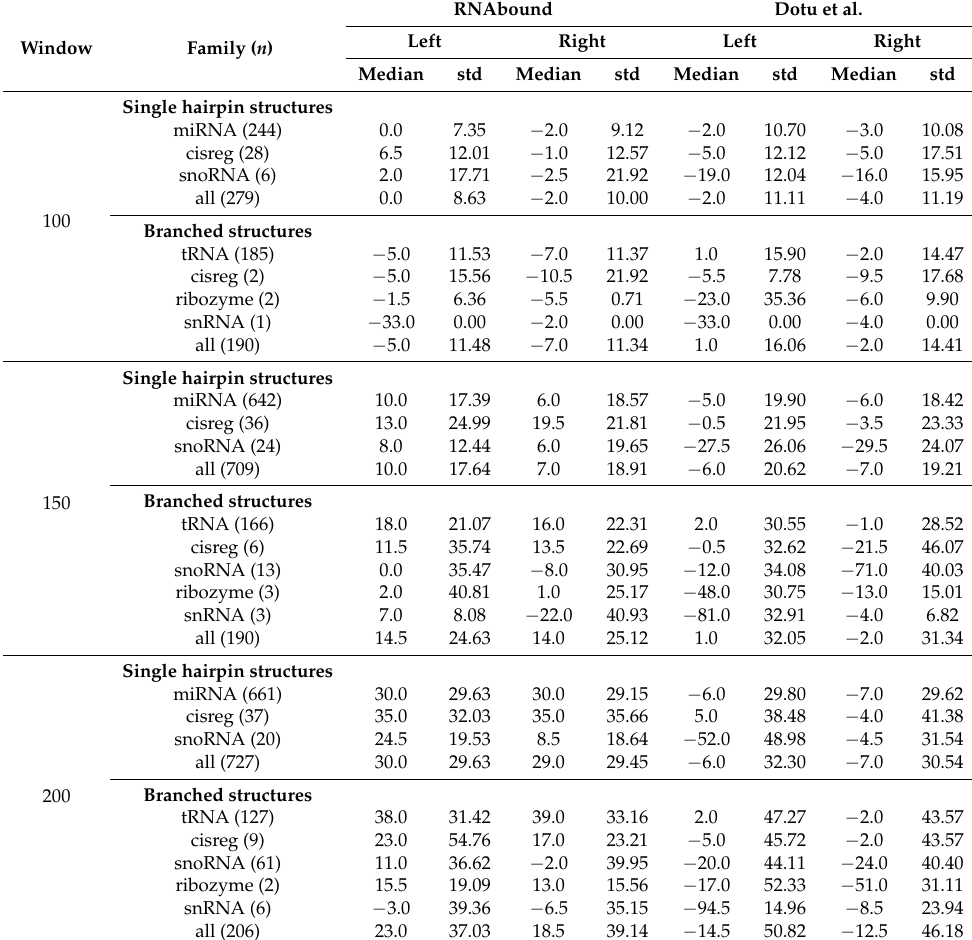
Table A2. Summary of boundary predictions from single sequences with RNAbound and Dotu et al. The base pair probabilities were calculated from the human sequences with RNAfold